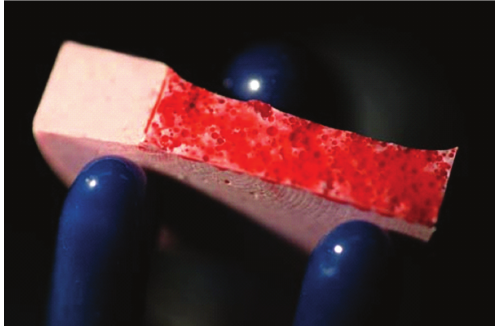
Figure 11: Close-up image of one-half of a self-healing epoxy specimen after it has been fractured into two pieces (Magnus Andersson, University of